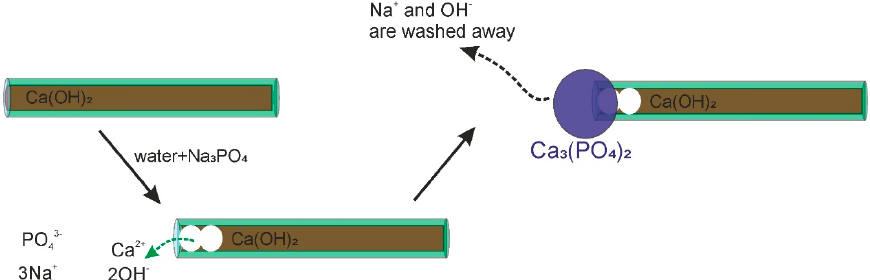
Figure 4. Sketch of the end-stopper formation.